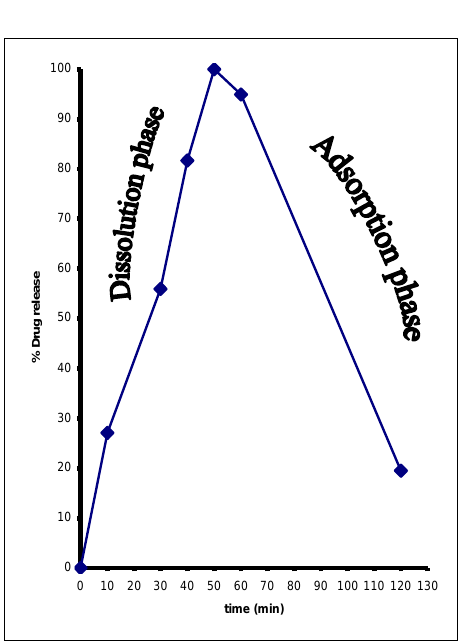
Figure 7: The percent of alpha-tocopherol acetate released from kaolin at pH 1.2 after 3 months of incubation period.